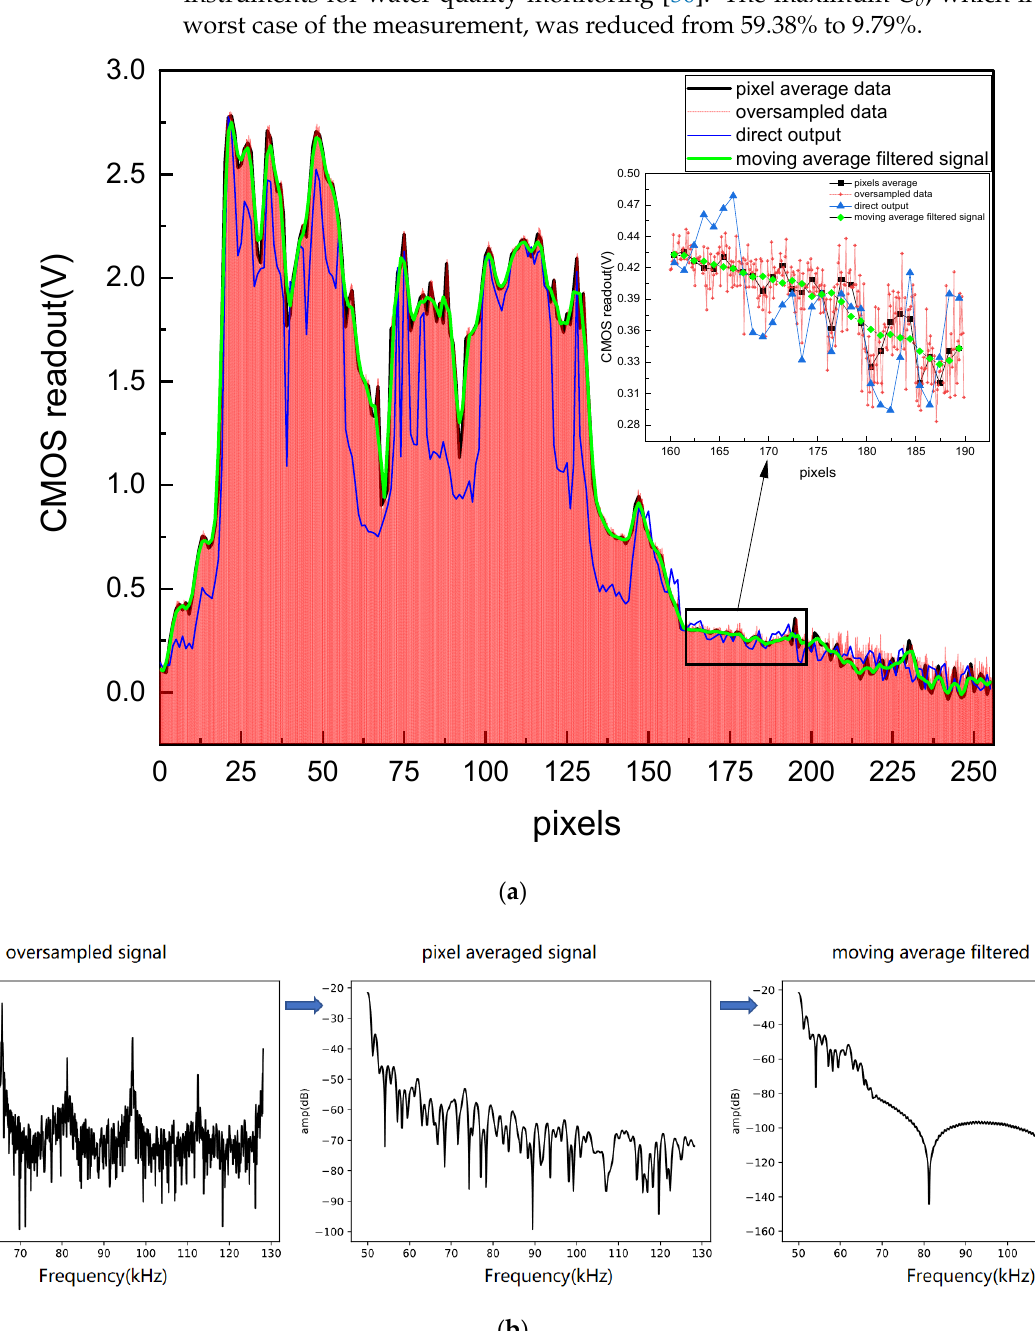
Figure 6. ( a ) Comparison of the readout spectrum data between the direct output of the CMOS image sensor, the average result from the oversampled data and the signal filtered by moving-average filter. ( b ) Comparison of the spectrum signal in frequency domain after pixels averaging and digital filter are